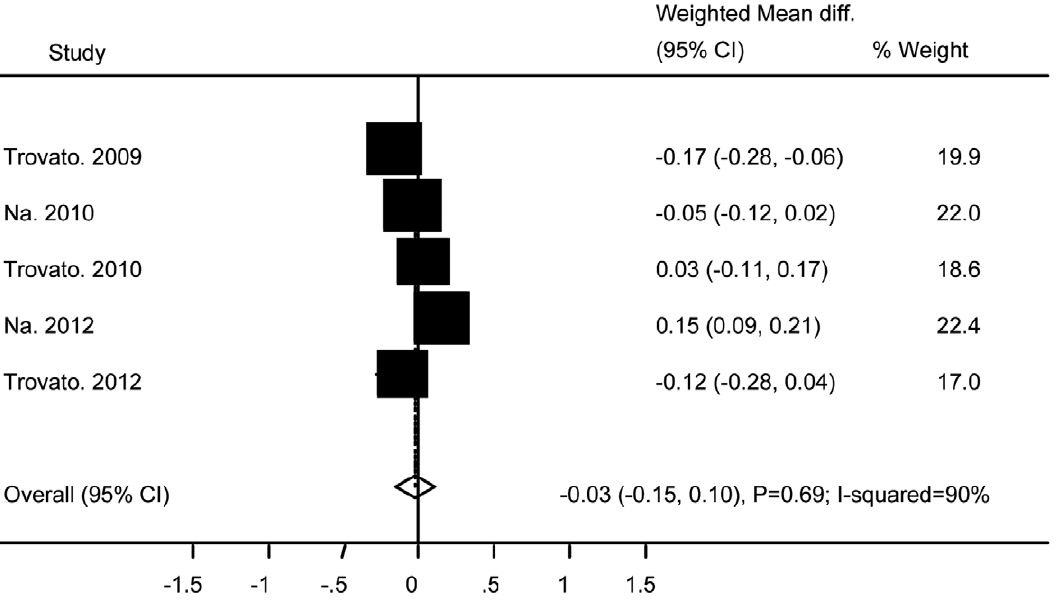
Figure 6. Association of Ad36 with High Density Lipoprotein.